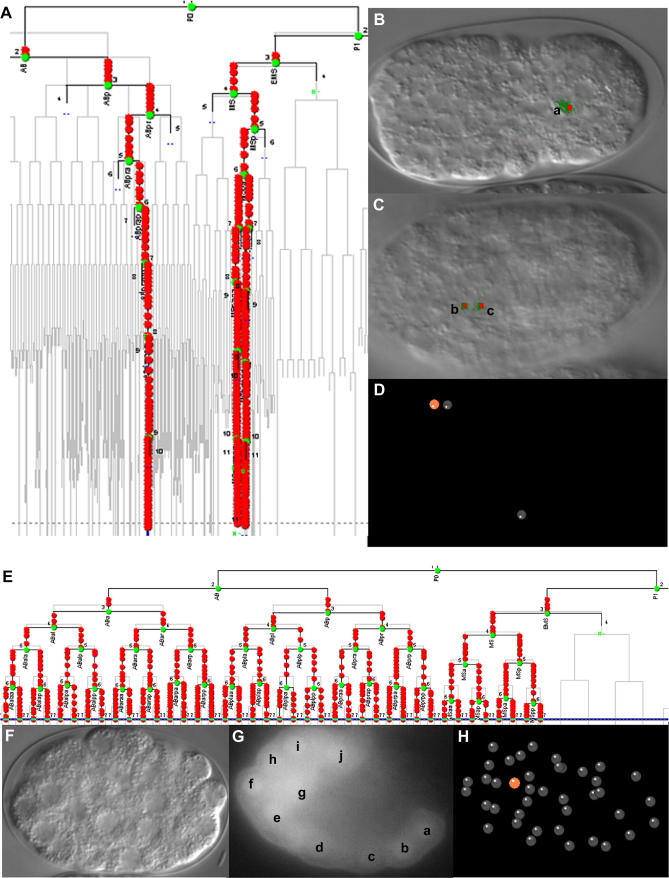
Embryonic Cell Lineages of C45G9.13 and ZK637.11(A) and (E) display the embryonic cell lineages of C45G9.13 and ZK637.11, respectively.(B) and (C) are Nomarski differential contrast microscopy images of C45G9.13 with a GFP overlap. The view is from the ventral side with anterior to the left of the image. The highlighted cells are a, ABprappppa; b, M5; and c, Mspapaapa.(F) and (G) show Nomarski images of ZK637.11 with ventral to the bottom and anterior to the left. The cells marked in (G) are a, ABprppa; b, ABprpap; c, MSppa; d, MSpaa; e, ABalaap; f, ABalpaa; g, ABalapp; h, ABalppa; I, ABplaap; and j, ABplapp.(D) and (H) are 3-D stick and ball models of the nuclei of the expressing cells of C45G9.13 and ZK637.11, respectively. In both panels, anterior is to the left and ventral is on the bottom. In (D), the orange ball represents M5: note that the embryo has been rotated 90° to the right compared to the above Nomarski image. In (H), the orange ball corresponds to ABalapp.